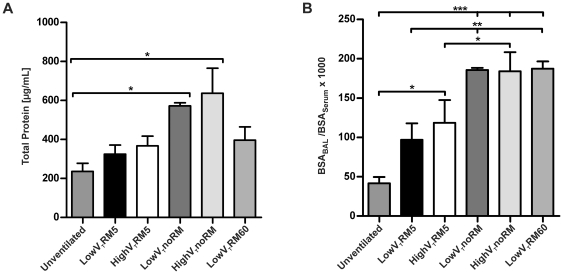
Protein leakage.
A. Total protein levels were measured with DC protein assay. (Unventilated n = 5, lowVTRM5 n = 6, highVTRM5 n = 6, lowVTnoRM n = 4, highVTnoRM n = 4, lowVTRM60 n = 5). B. BSA was quantified in BAL and serum by ELISA and the ratio was calculated. (Unventilated n = 5, lowVTRM5 n = 5, highVTRM5 n = 5, lowVTnoRM n = 4, highVTnoRM n = 4, lowVTRM60 n = 5). * p<0.05, ** p<0.01, *** p<0.001.